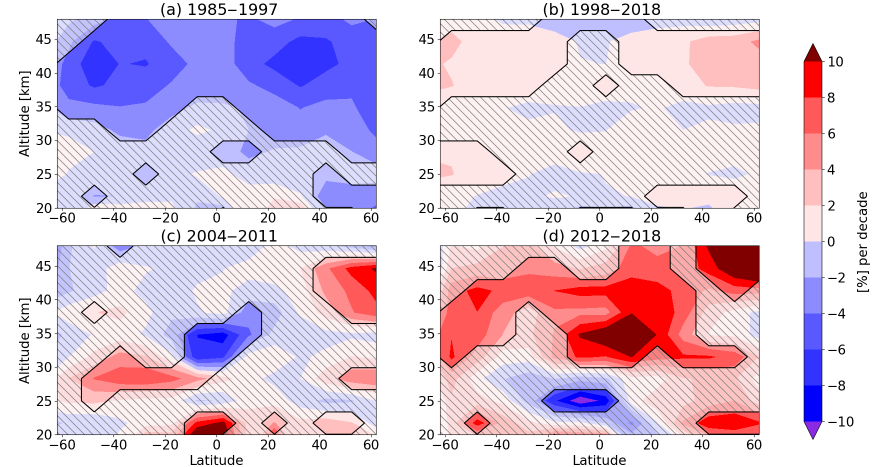
Figure 9. Zonal mean trends computed using the merged SAGE II, SCIAMACHY and OMPS-LP data set, in panel (a) over the 1985–1997 period, in panel (b) from 1998 to 2018, in panel (c) over 2004–2011 (SCIAMACHY observation period) and in panel (d) over 2012–2018 (OMPS-LP observation period). Dashed areas show non-significant